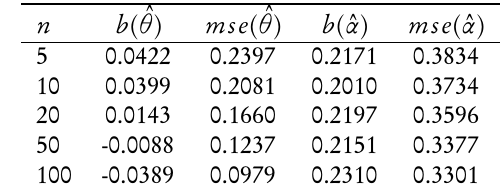
θ = 7.75 and α = 6.80